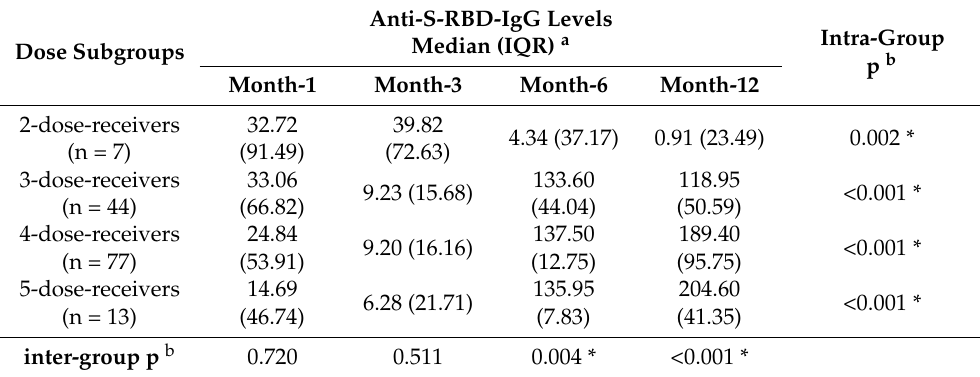
Table 4. Change in the antibody levels over time according to the vaccine-dose